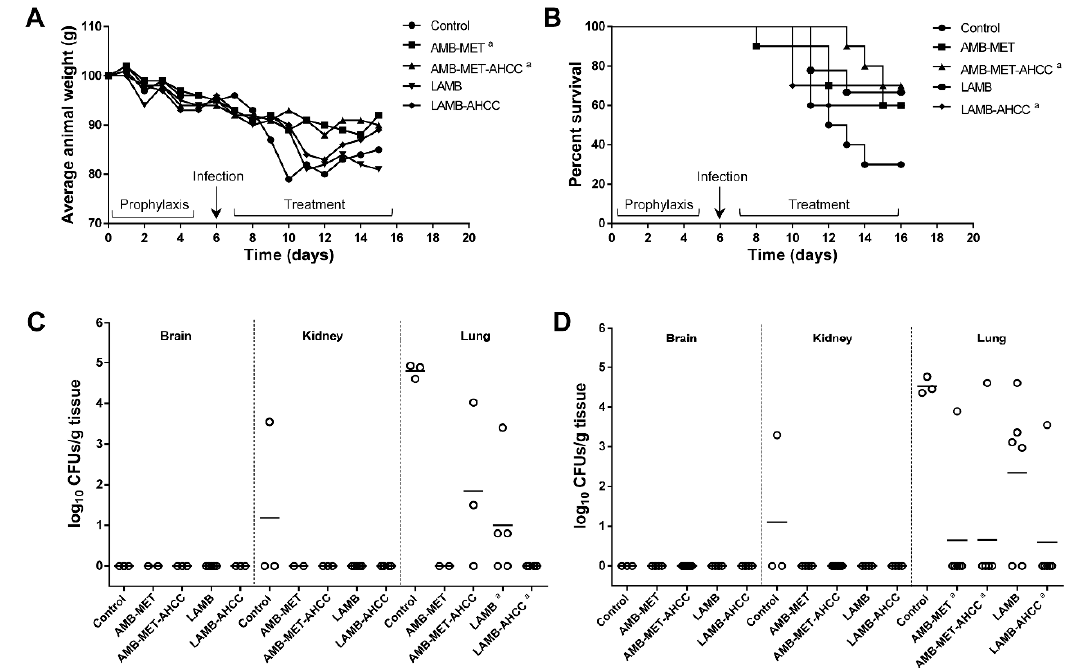
Figure 1. Effect of AMB-MET p.o. and LAMB i.v. with and without AHCC ® supplementation in immunosuppressed mice infected intranasally with Aspergillus fumigatus . ( A ) Progression of body weight. ( B ) Percent of surviving mice. Panels ( C ) and ( D ) show scattergram and median (horizontal lines) of CFUs recovered from targeted organs at 6 and 11 days after infection, respectively. a Indicates statistically significant differences ( P < 0.05) in comparison to the control group.